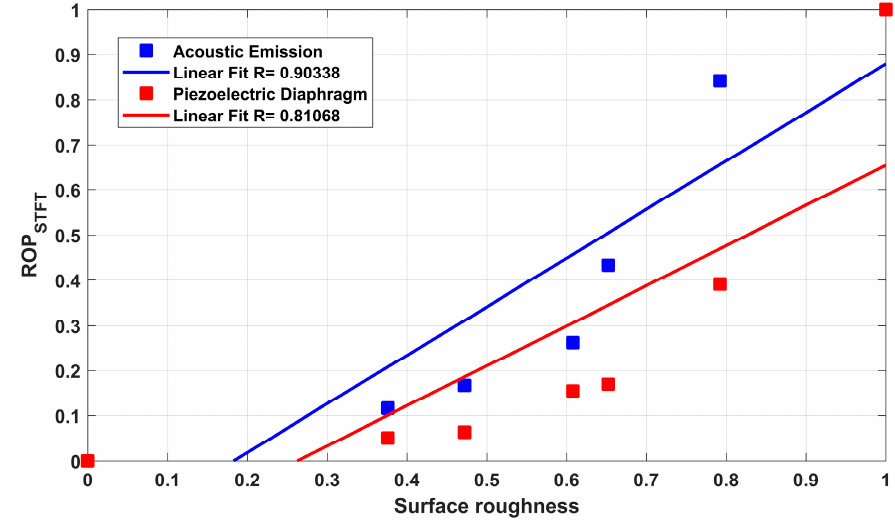
Figure 7. Correlation between ROP and surface roughness for both sensors .